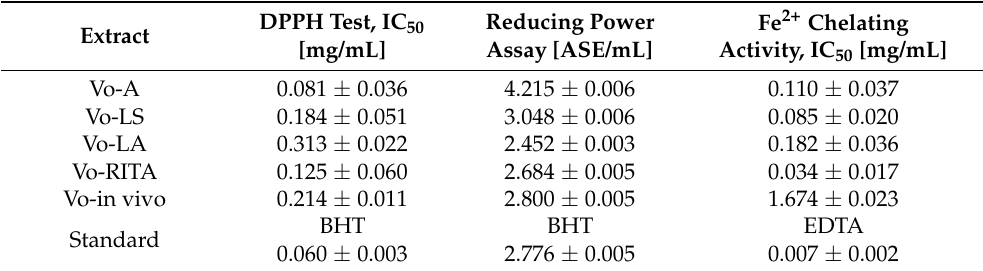
Table 4. Determination of free radical scavenging activity (DPPH test), reducing power, and ferrous ion (Fe 2+ ) chelating activity of extracts of V. officinalis in vitro cultures; agar (Vo-A), stationary liquid (Vo-LS), agitated (Vo-LA) and bioreactor cultures (Vo-RITA) and of plant material (Vo-in vivo).Values are expressed as mean ± SD (n = 3).